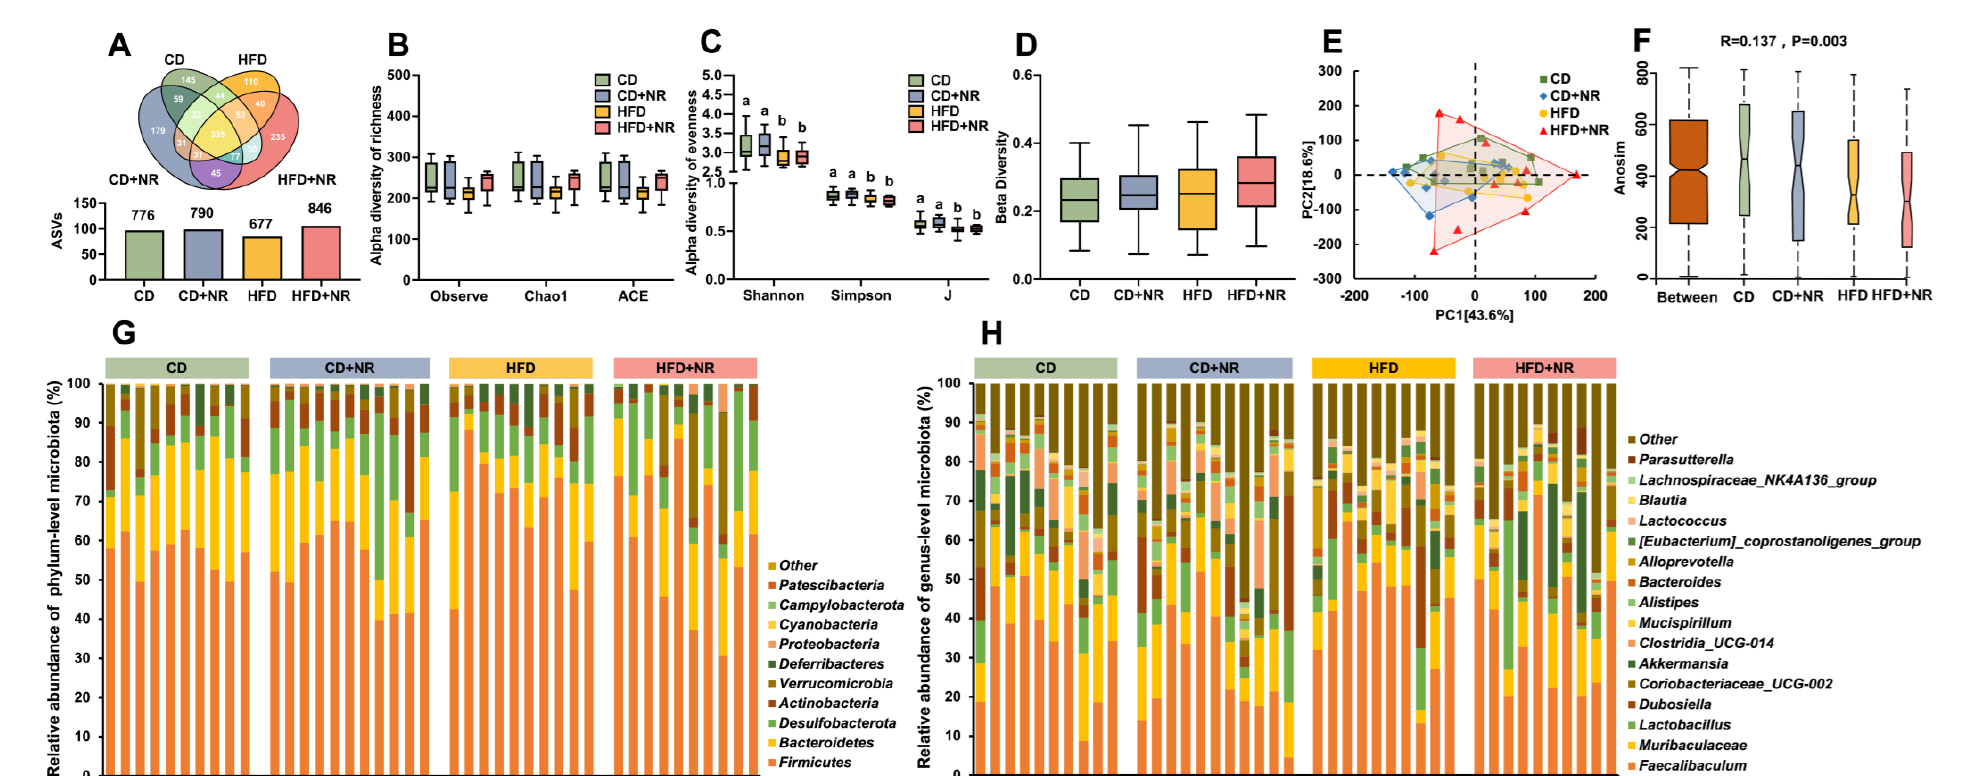
Figure 4. Gut microbial composition and diversity in ApoE −/− mice fed with a CD or HFD, without or with NR at the end of the study. ( A ) Venn diagrams; ( B ) α -diversity of richness: Observe, Chao 1, ACE; ( C ) α -diversity of evenness: Shannon, Simpson, J indexes; ( D ) β -diversity; ( E ) Principal component analysis (PCA) based on ASVs level; ( F ) ANOSIM analysis diagrams; ( G ) Relative abundance of phylum-level microbiota; ( H ) Relative abundance of genus-level microbiota. Data were presented as mean ± SEM. A statistical analysis was performed using a two-way analysis of variance (ANOVA) with the main effects of diet and NR and diet*NR interaction. Means with different letters (a or b) indicated a significant difference from each other. CD (control), n = 10; CD + NR, n = 11; HFD, n = 10; HFD + NR, n = 10. CD, control diet; HFD, high-fat and high-cholesterol diet; + NR, a diet plus oral gavage with 0.3 g/kg BW/day of NR.